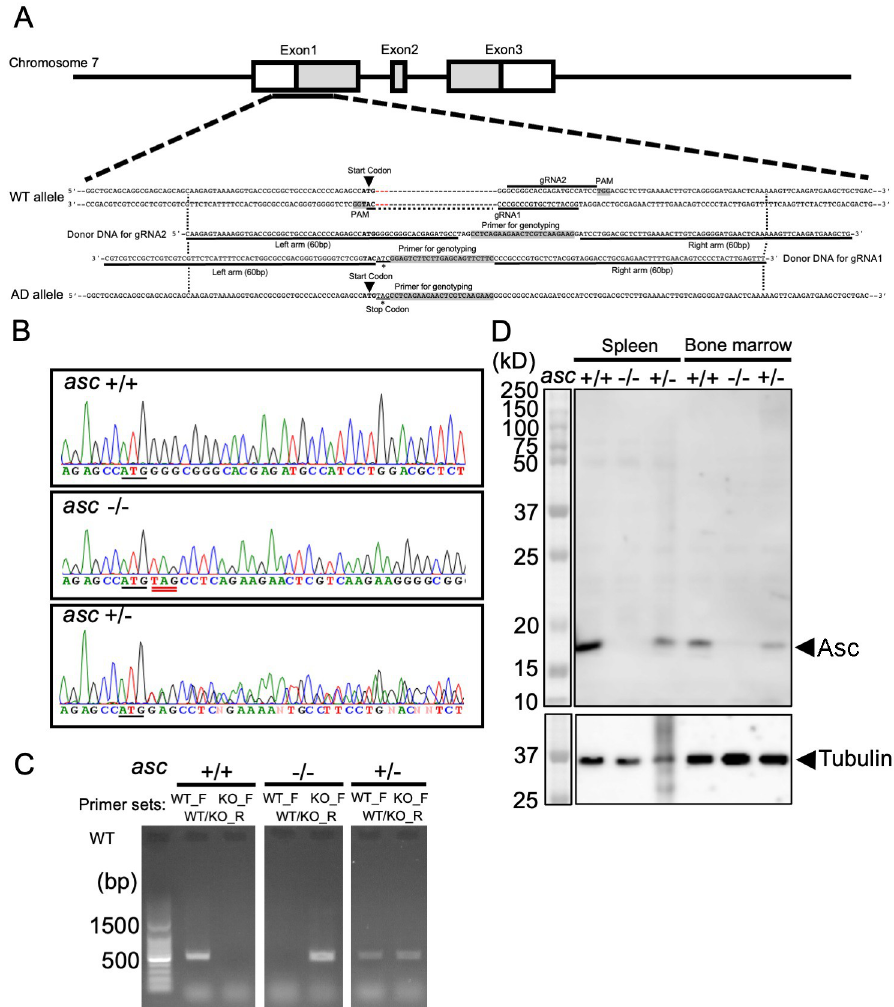
Fig 1. Generation of AD mice. (A) Schematic representation of the locus of the asc/pycard gene, the doner DNAs for gRNA1 and gRNA2, and the mutated allele. The location of the primer used for PCR is also indicated. (B) The edited sequence was confirmed by DNA sequencing using a conventional Sanger method. (C) Mutation-specific PCR using the specific primer sets indicated in Table 1. (D) Western blot analysis of ASC expression in bone marrow and spleen lysates from wild-type homozygote mice ( asc +/+), and AD homozygote mice ( asc -/-) and heterozygote mice ( asc +/-). Tubulin was used as a loading control.